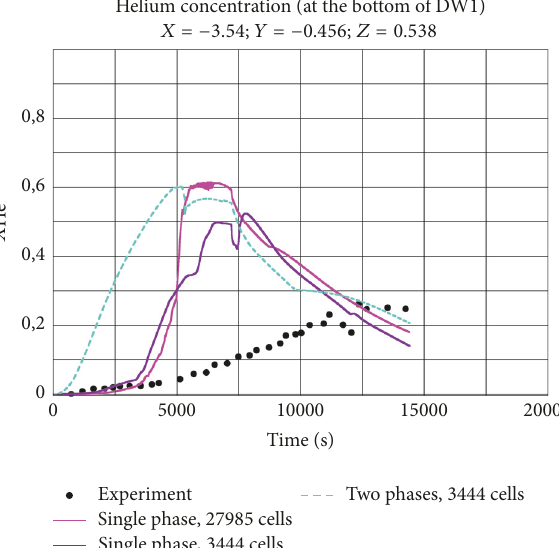
Figure 10: Helium concentration at the bottom of DW1. Without heat and mass transfer, the momentum exchange between droplet and gas is correctly predicted, which is of relevant interest to evaluate discrepancies for ST3 2 test where mass, momentum, and energy exchanges